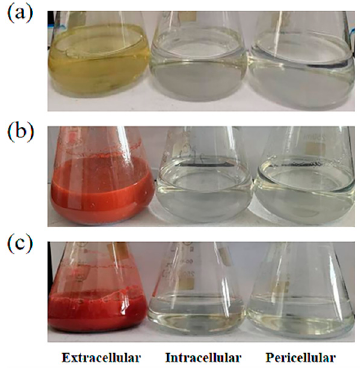
Figure 4. Reduction in SeO 32 − by extracellular, pericellular, and intracellular extracts of Bacillus sp. Q33 containing 5 mM Na 2 SeO 3 . ( a ) 4 h ( b ) 12 h ( c ) 24 h.